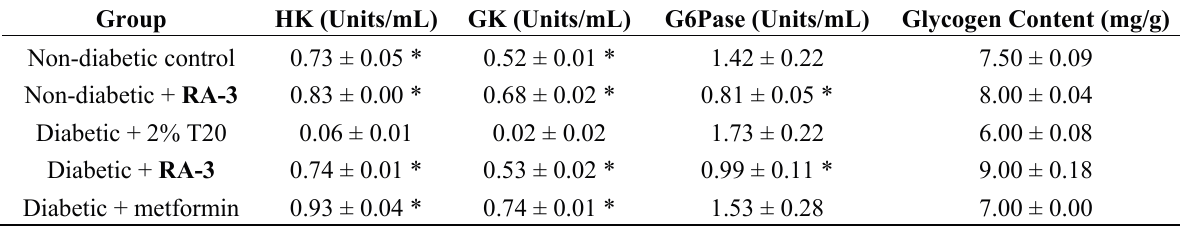
Table 2. Effect of RA-3 on hepatic glycogen content, HK, GK and G6Pase activity in the diabetic treated animals.